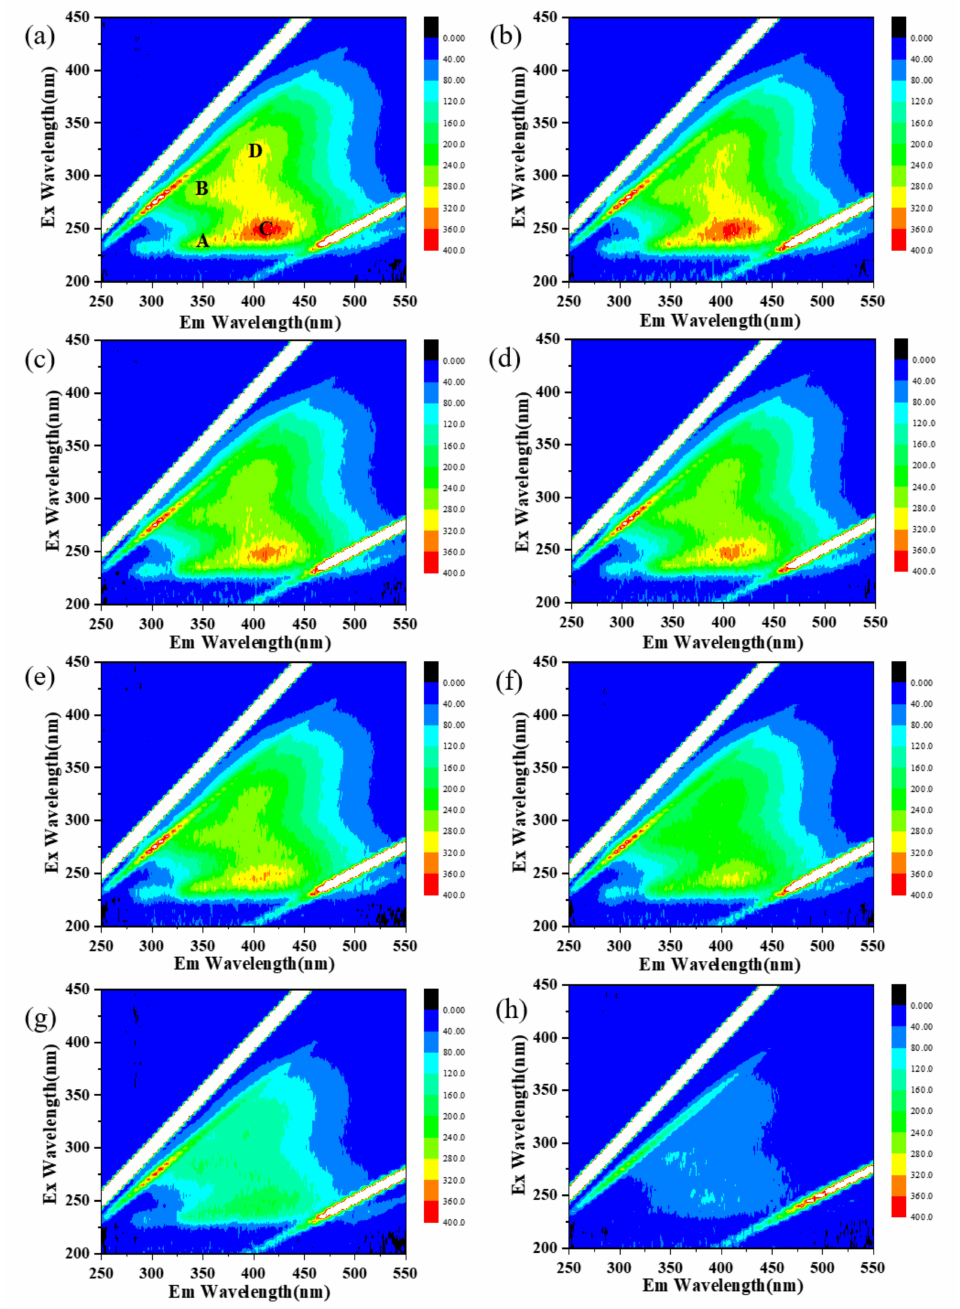
Figure 4. Fluorescence EEM spectra of organic matters in the permeate water of UF under different concentrations of Fe(II)/PMS: ( a ) control; ( b ) 30 µ M PMS; ( c ) 60 µ M PMS; ( d ) 30 µ M Fe(III); ( e ) 60 µ M Fe(III); ( f ) 30/30 µ M/ µ M Fe(II)/PMS; ( g ) 60/60 µ M/ µ M Fe(II)/PMS; and ( h ) 120/120 µ M/ µ M